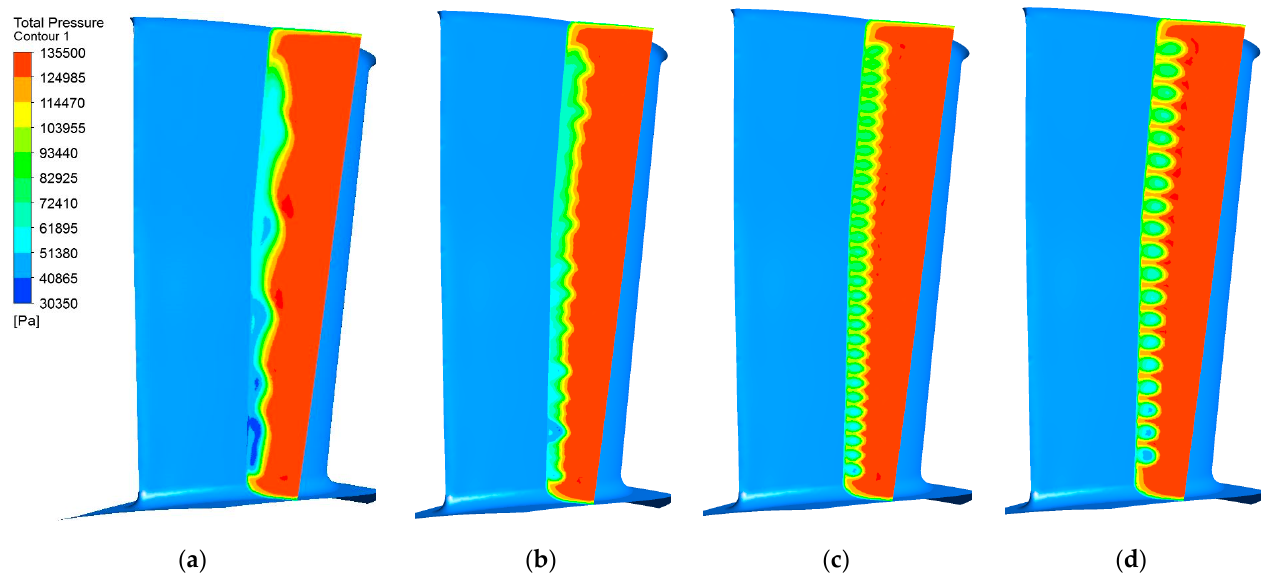
Figure 8. Total pressure distribution downstream of the injection section for: ( a ) ∅ (cid:3036)(cid:3041)(cid:3037) = 0.4 mm ; ( b )